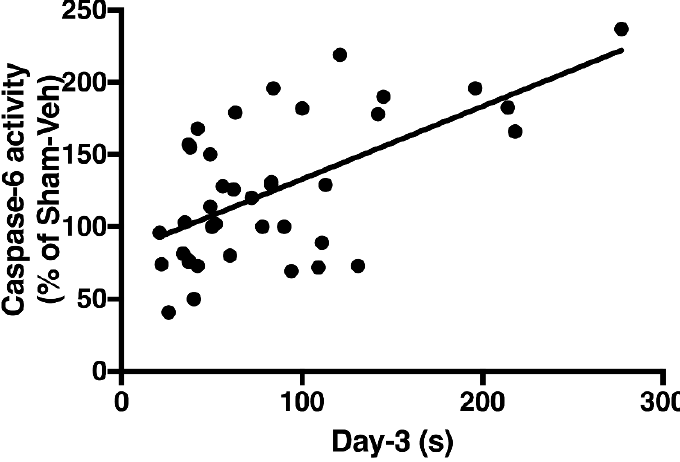
Figure 7. Correlation between spatial memory performance and caspase-6 activity in the CA1 region of the hippocampus 4 months after surgery. Data are taken from day 3 With all groups of rats pooled together, the linear regression test showed a significant positive correlation between the time needed to reach the target platform (on day 3 of a 6 days series—see Figure 4). r 2 = 0.36; p < 0.05.